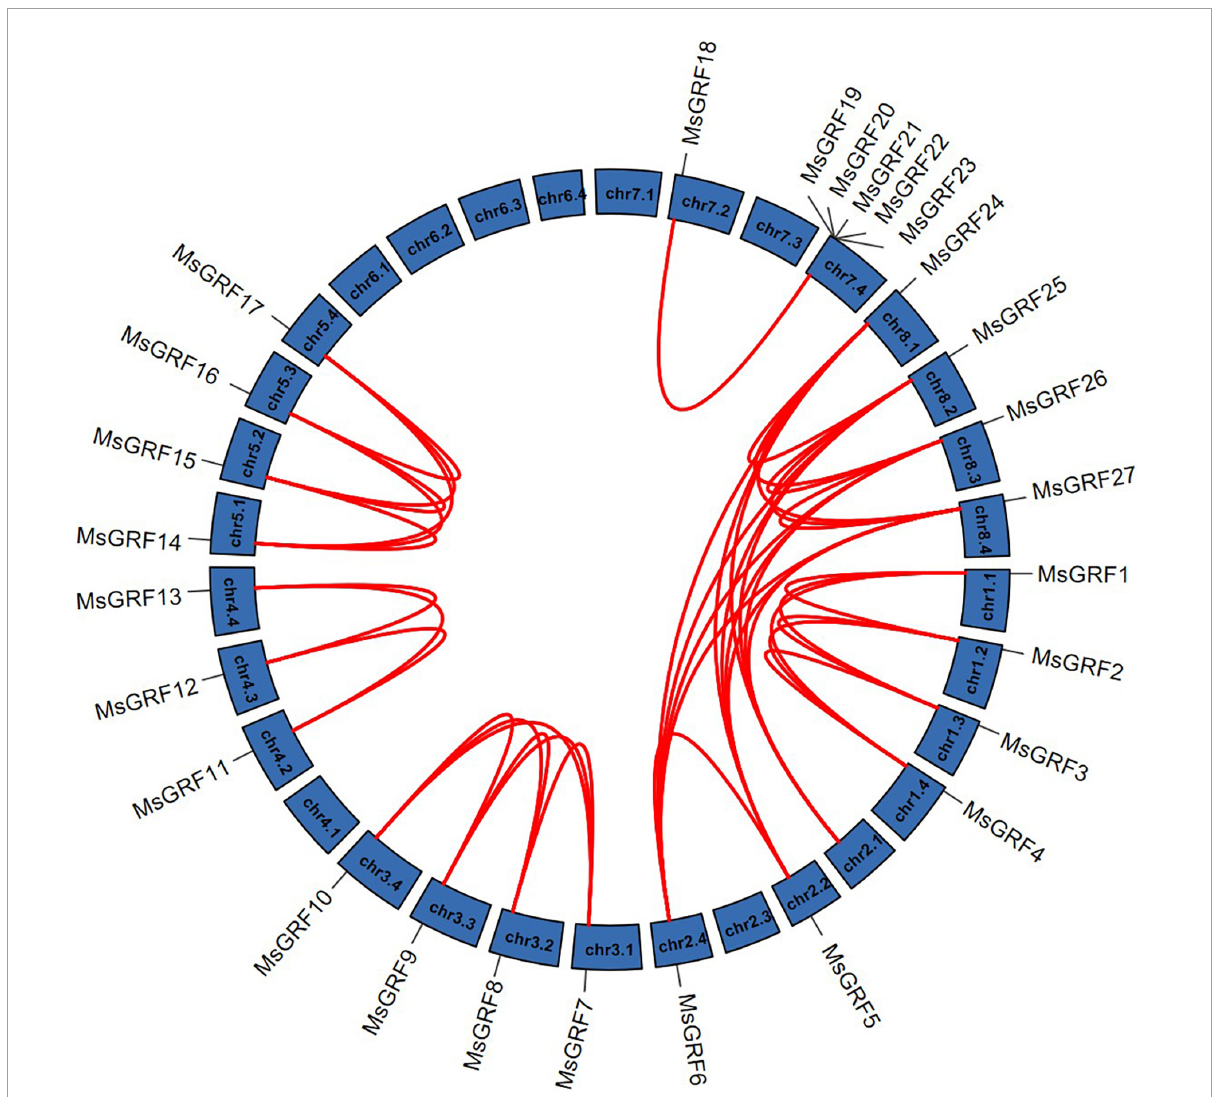
FIGURE4 Synteny analysis of MsGRFs genes in alfalfa. Red lines indicate the replicated MsGRFs gene pairs in